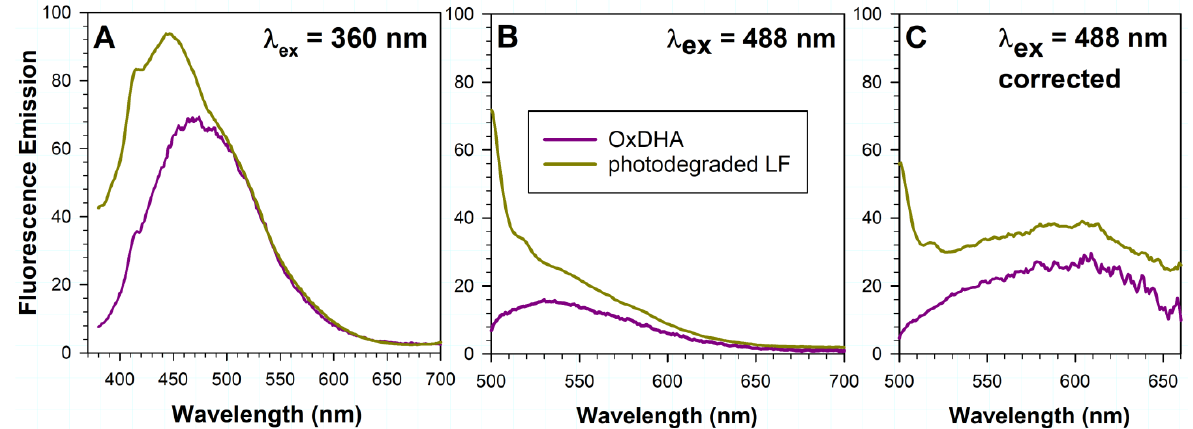
Figure 2. Fluorescence emission of oxidized docosahexaenoate (OxDHA) may contribute to the emission of photodegraded lipofuscin. Representative fluorescence emission spectra of oxDHA and photodegraded lipofuscin (LF) granules obtained by excitation with 360 nm ( A ) and 488 nm ( B ) light. ( C ) Fluorescence emission spectra from ( B ) corrected for the spectral changes in sensitivity of the detector. Prior to fluorescence measurement, lipofuscin was photodegraded by irradiation for 10.5 h with 9.76 mW/cm 2 visible light providing radiant exposure of 369 J/cm 2 . OxDHA was obtained by auto-oxidation of phosphatidylcholine with two DHA acyl chains. The concentration of OxDHA used for fluorescence measurements corresponds to 4.23 mg/mL of the non-oxidized phospholipid.